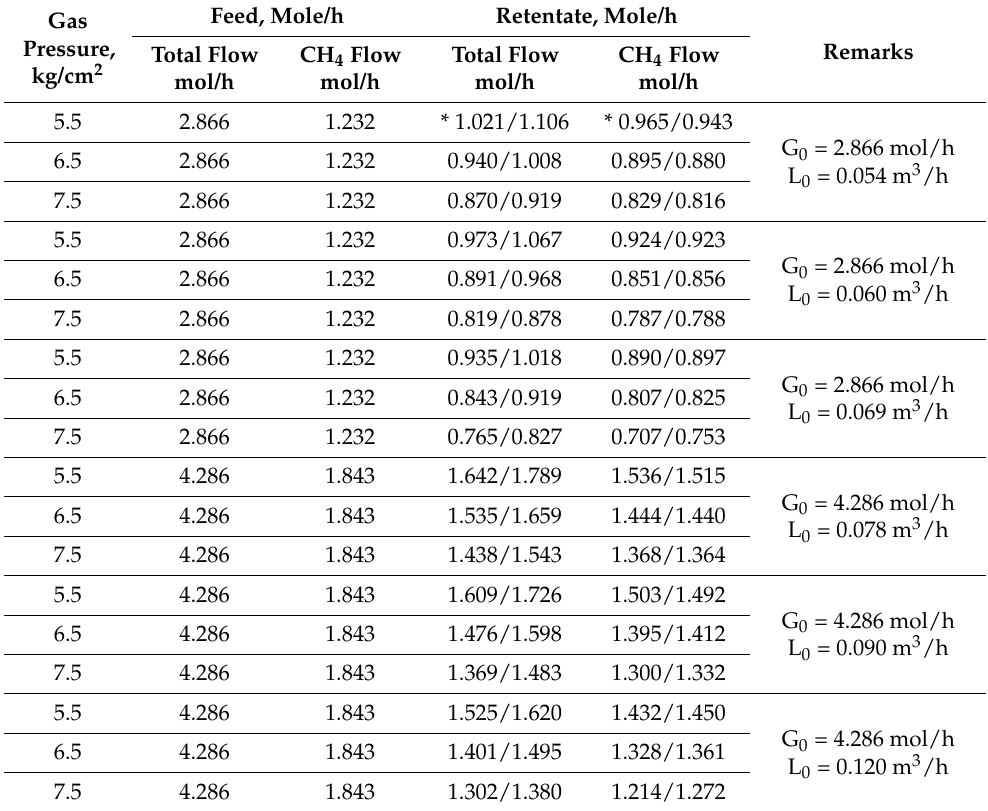
Table 2. A comparison of simulated retentate gas flow rate to experimental value in purification of CH 4 by membrane contactor at various feed pressures and flow rates through porous PP hollow fiber membrane with OD/ID = 1000/700 µ m and a porosity of 58%, number of HF in membrane module = 700, effective membrane length = 29 cm, membrane area = 0.64 m 2 and the determined R-value = 0.155. *( )/( ): *experimental value/simulated